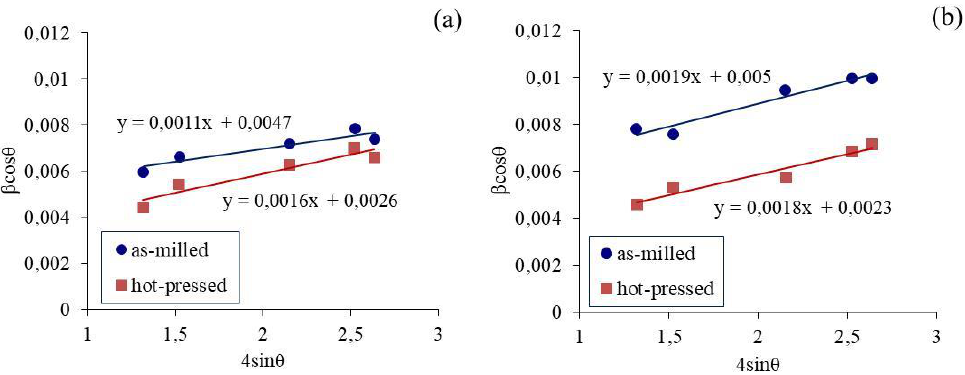
Figure 5. The Williamson-Hall plots for ( a ) Al-5TiO 2 -2PCA and ( b ) Al-5TiO 2 -5Cu composites. Table 2. Microstructural parameters of the aluminum matrix obtained by XRD analysis and mi- crohardness for different